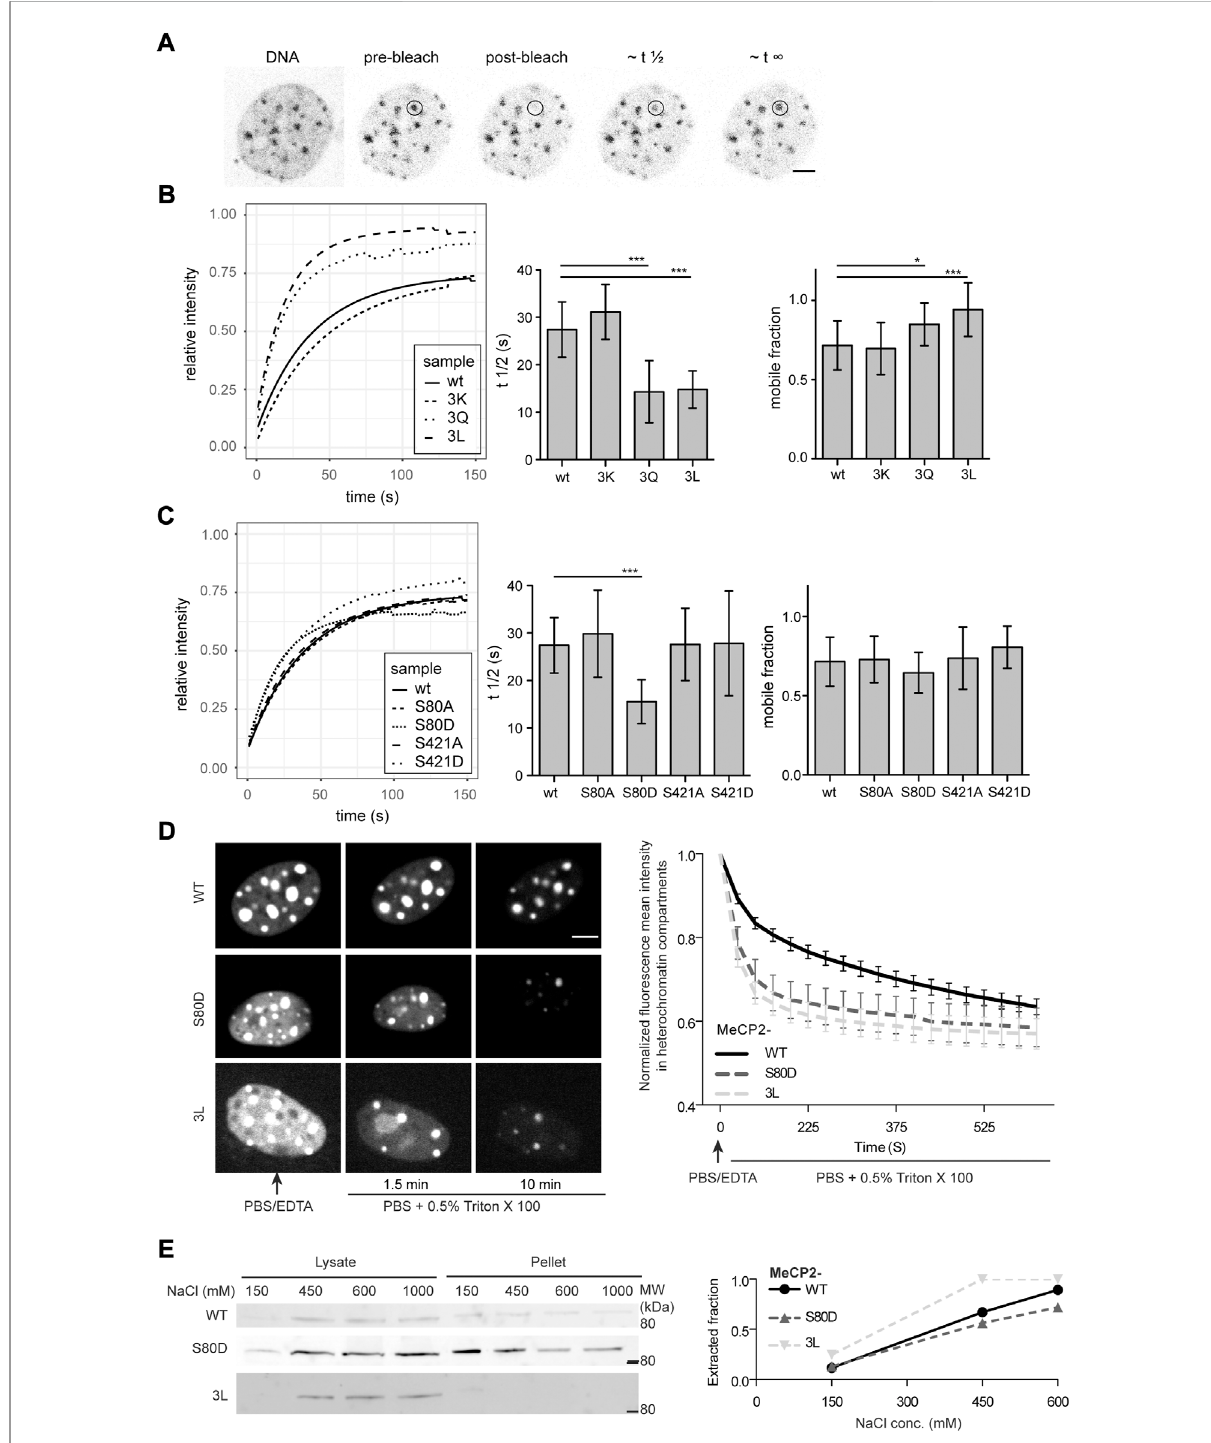
FIGURE 4 Analysis of the dynamics of MeCP2 mutants in cells. (A) Exemplary MTF Mecp2 -/y cell transfected with wild type MeCP2 expression construct stainedwith thecell-permeableDNAdyeSIRHoechstandGFPsignalisshown pre-bleaching,post-bleachingandduring fl uorescencerecovery. (B) Fitted time curves for fl uorescence recovery after photobleaching and bar diagrams showing the recovery half times (t ½) and mobile fractions for MeCP2 wild type (wt) and 3K, 3Q, and 3L mutations including R91, R162, and R167 (B) as well as for S80 and S421 mutations (C) . p -values calculatedbyWilcoxon-Ranktest.** p < 0.05,*** p < 0.001. p -valuesandn-valuesaresummarizedinSupplementaryTableS6,singlerecoverycurves with standard deviation are plottedin SupplementaryFigureS9. (D) In situ extractionof MeCP2 mutants expressed inC2C12 mouse cells. Shown